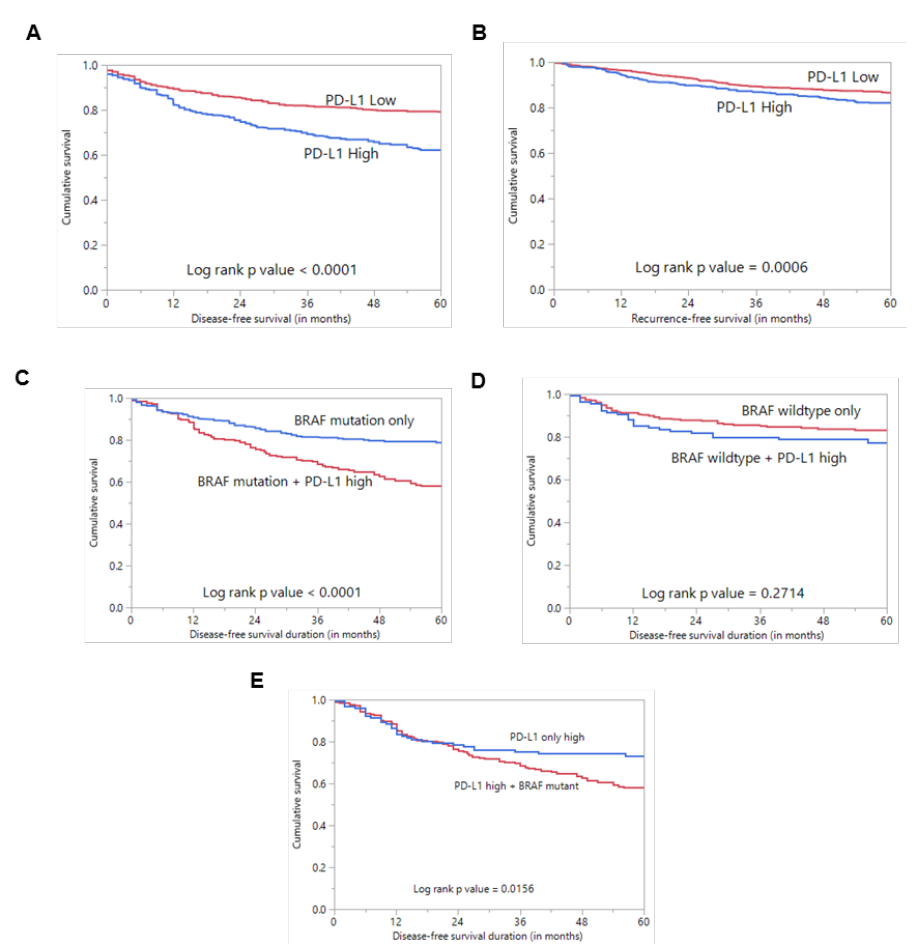
Figure 2. Survival analysis of PD-L1 protein expression. ( A ) Kaplan–Meier survival plot showing statistically significant poor disease-free survival in PD-L1 high-expression cases compared to PD-L1 low expression ( p < 0.0001). ( B ) Kaplan–Meier survival plot showing statistically significant poor recurrence-free survival in PD-L1 high-expression cases compared to PD-L1 low expression ( p = 0.0006). ( C ) Kaplan–Meier survival plot showing statistically significant poor disease-free sur- vival in cases with co-existing PD-L1 expression and BRAF mutation compared to cases with BRAF mutation alone ( p < 0.0001). ( D ) Kaplan–Meier survival plot shows no statistically significant difference in disease-free survival in cases with co-existing PD-L1 expression and wildtype BRAF compared to cases with wildtype BRAF alone ( p = 0.2714). ( E ) Kaplan–Meier survival plot showing statistically significant poor disease-free survival in cases with co-existing PD-L1 expres- sion and BRAF mutation compared to cases with PD-L1 expression alone ( p = 0.0156).